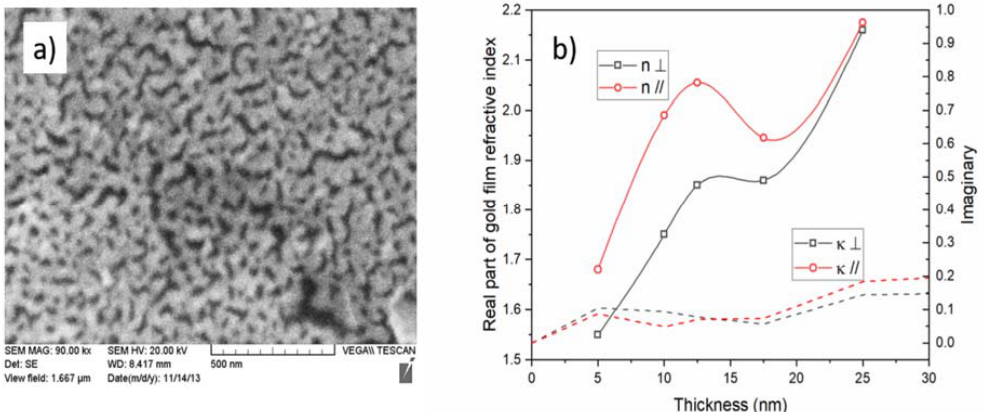
Figure 12. ( a ) Scanning electron micrograph (SEM) image of 20 nm thick gold film deposited by electron beam physical deposition; ( b ) effective parameters of the complex refractive index (n-i κ ) of CVD gold coatings as a function of average thickness, determined from the TFBG resonance shifts at wavelengths near 1550 nm (adapted with permission from [38]. Copyright (2014) American Chemical